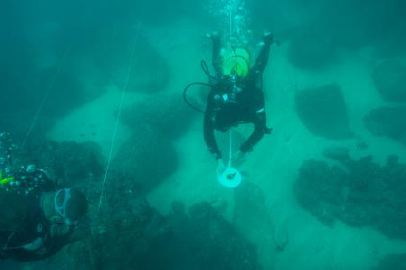
Figure 4. Preparing the first part of the site in 2014 (photo by Ashraf Hussein)